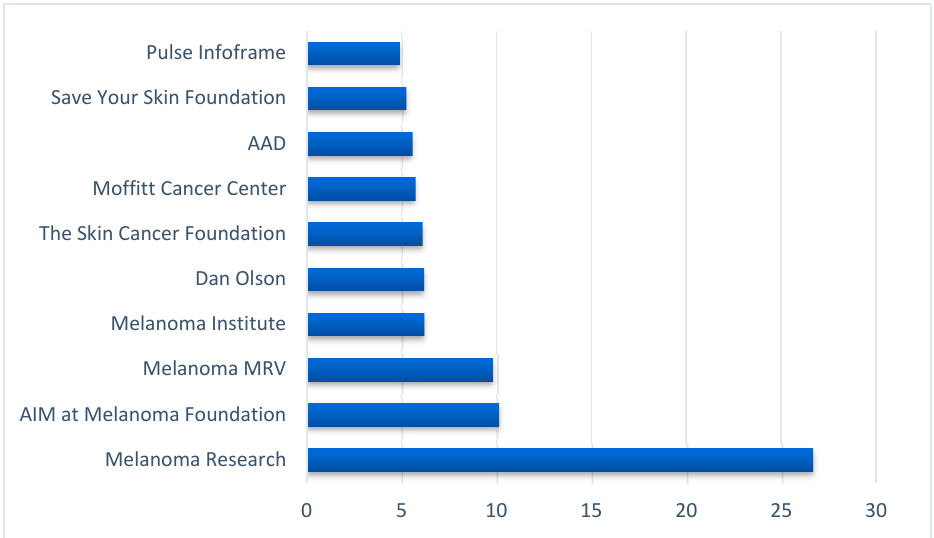
Figure 2. Top Influencers in the melanoma network on Twitter ranked by the betweenness centrality scores.